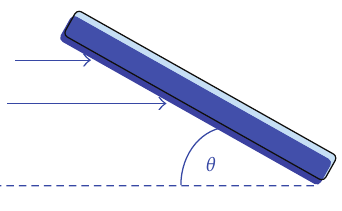
Figure 4: Modified